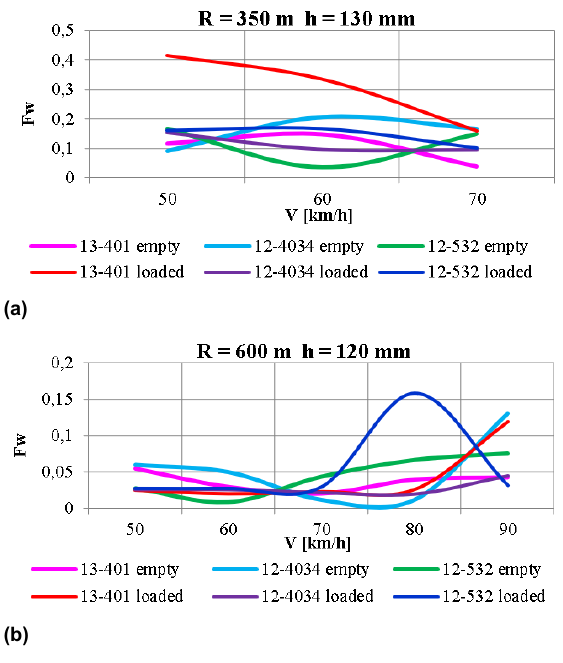
Figure 18. Variation of the wear factor of the side edge of the wheel tread with the motion speed: (a) R=350 m curve; (b) R=600 m